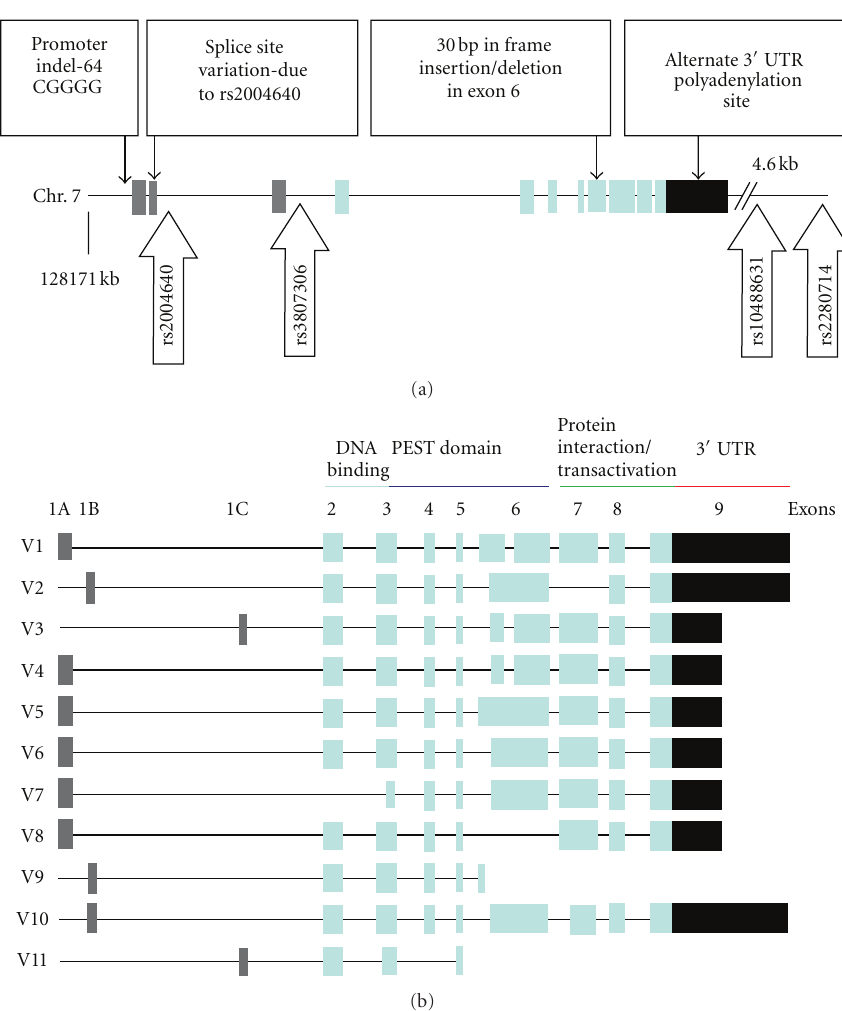
Figure 2: (a) IRF5 gene marked with previously reported functional variants along with studied SNPs [64]. The first three grey boxes represent di ff erentially spliced first exons (1A, 1B, and 1C), the next light blue boxes represent the exons 2–9, and the last black box indicates the 3 (cid:2) UTR. SNPs rs2280714 and rs10488631 were used as proxies for rs10954213 in the 3 (cid:2) UTR due to high LD. (b) IRF5 mRNA isoforms